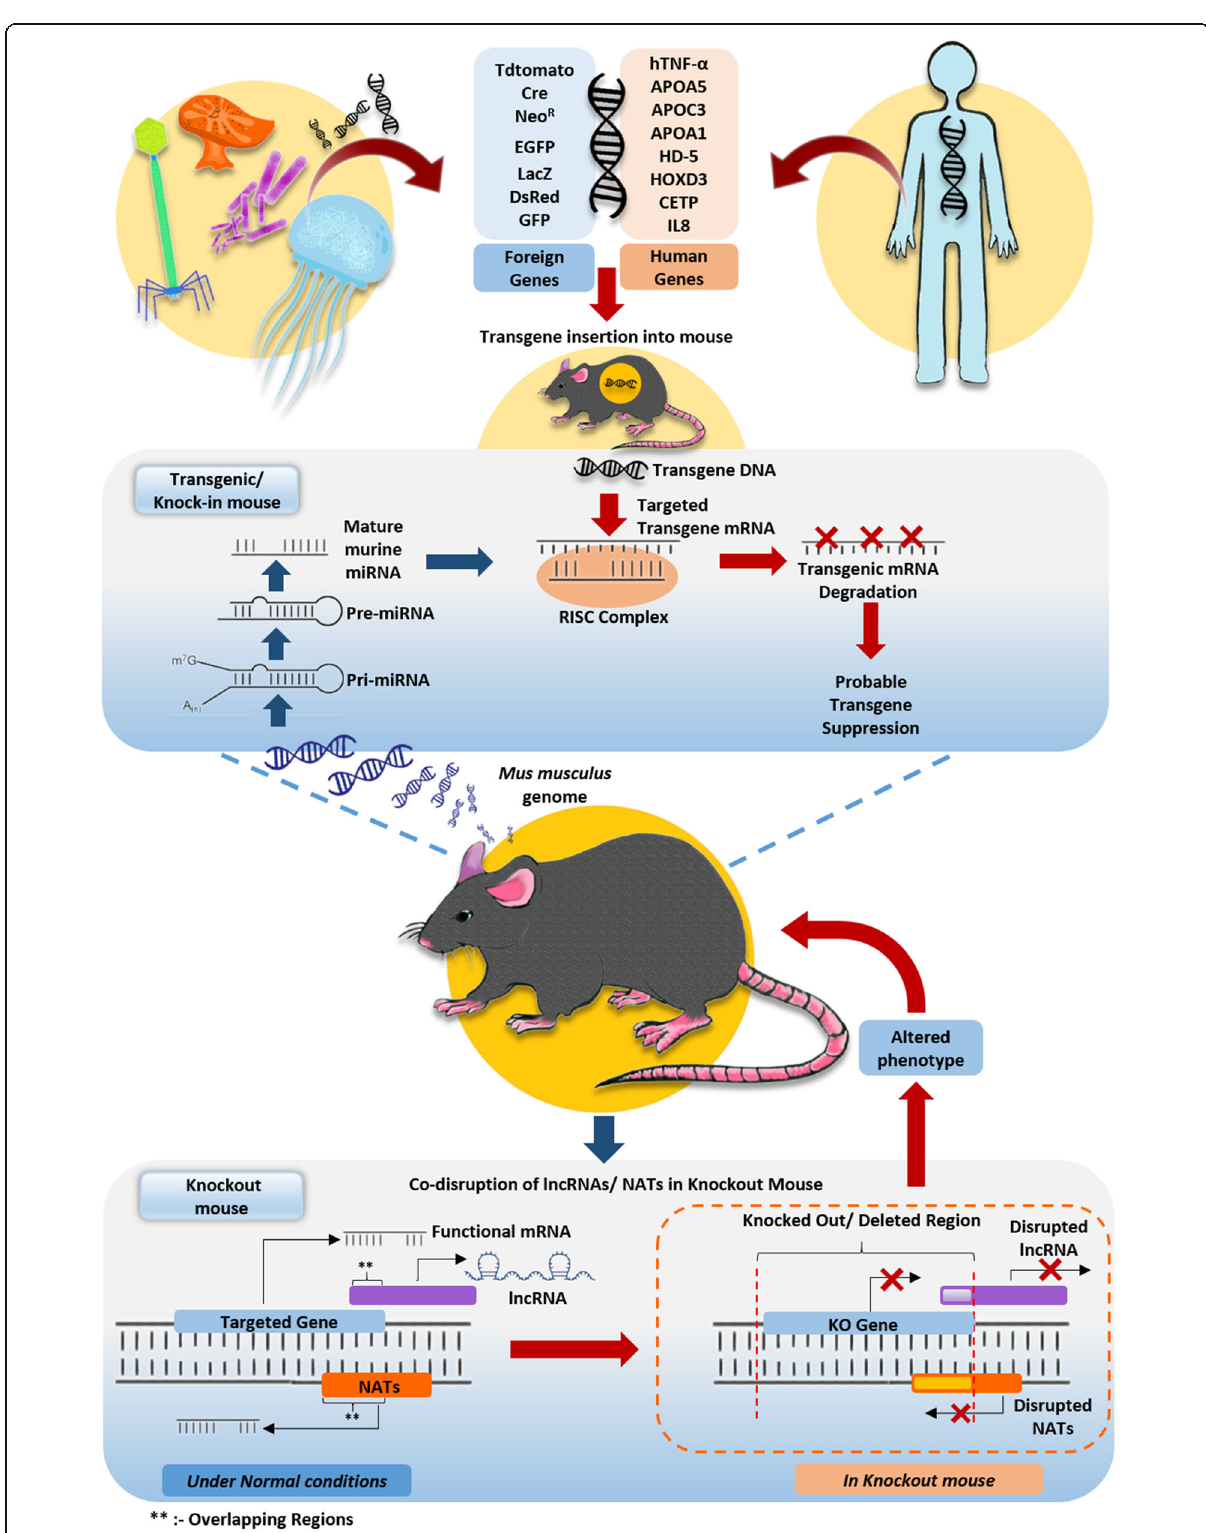
Fig. 1 Probable mechanisms of inadvertent sequence changes in transgenic mice. Genes of foreign origin such as those from humans and marker genes become potential targets of murine miRNAs once expressed within the cells of knockin/transgenic mice. Non-coding elements such as NATs and lncRNAs may get co-disrupted along with the target gene and contribute to the resulting phenotype of the